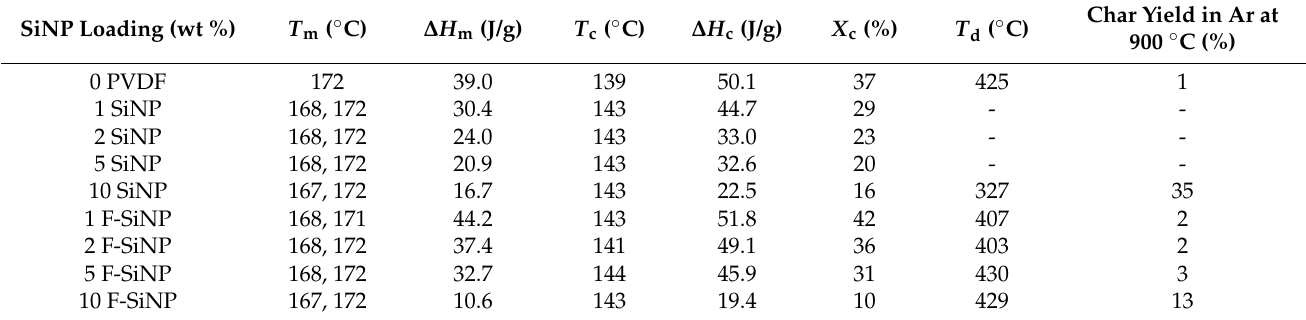
Table 1. Selected thermal analysis data of solvent-blended SiNPs and F-SiNPs. PVDF composites.